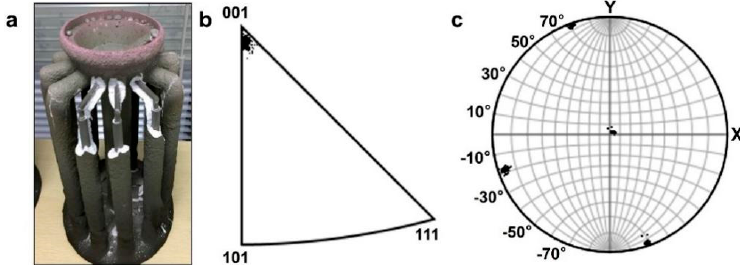
Figure 1. ( a ) Photograph of the single crystal (SX) rods in the mold. Inverse pole figure ( b ) and pole figure ( c ) obtained from one of the SX rods in ( a ), indicating that the crystal growth direction is along the [001] direction.